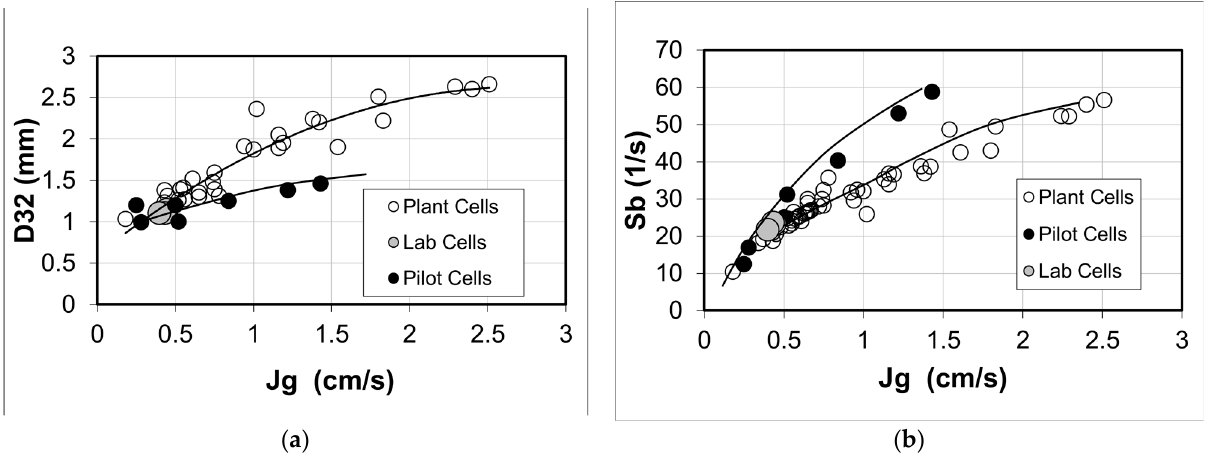
Figure 4. The ( a ) D 32 and ( b ) S b versus J g relationships for plant and pilot cells at the expansion. The significantly smaller bubble size of the pilot cells combined with their shallower froth depth (5 cm in the pilot cells versus 70 cm in the plant) results in a higher water